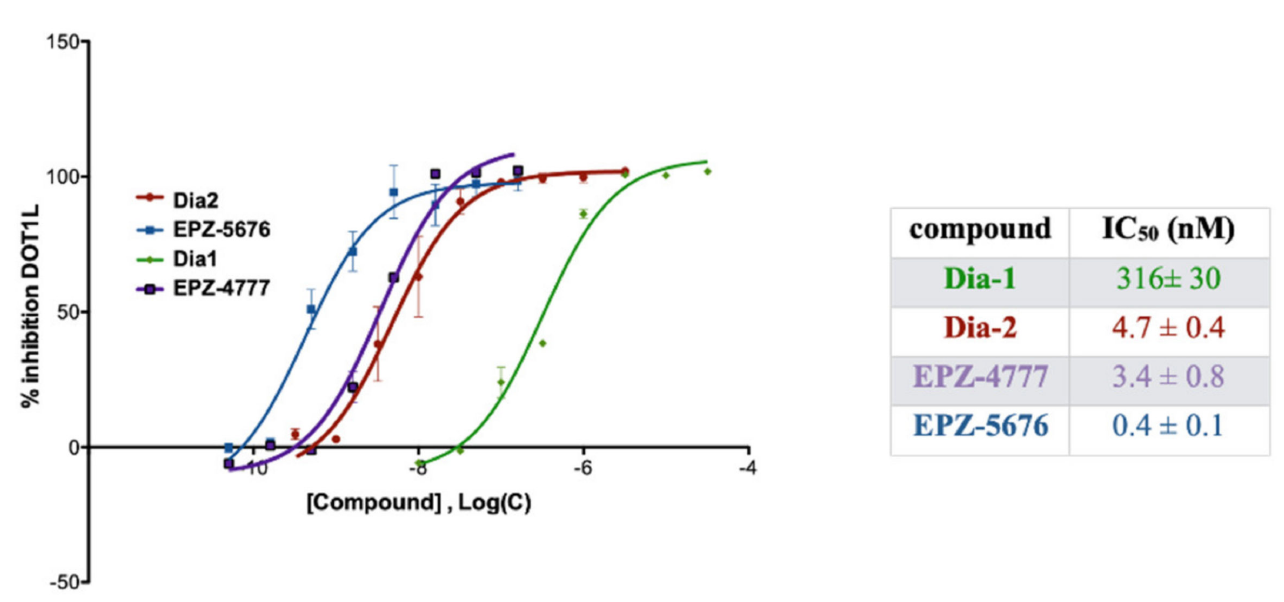
Figure 2. Inhibition of recombinant human DOT1L by Dia1 (red), Dia2 (green), EPZ-5676 (blue) and EPZ-4777 (violet). Each data point represents the mean of three technical replicates and two separated experiments at each specified concentration of the compound. The values of IC 50 are given in